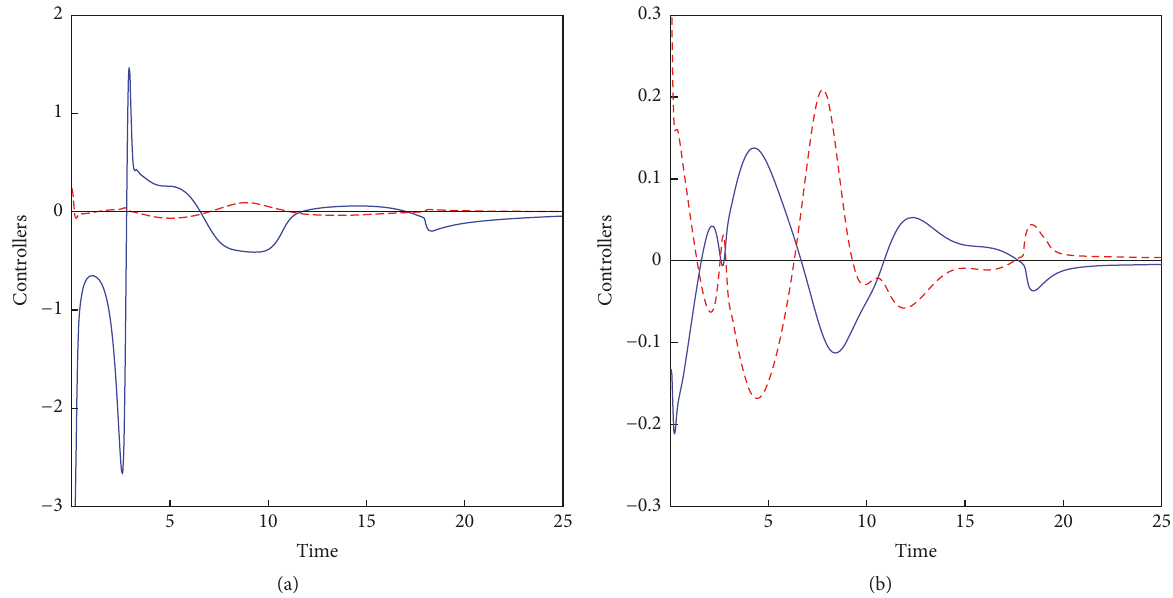
Figure 6: The time evolution of the acceleration-based controllers of the lead-carrier shown in (a) for the wheeled platform and (b) for the 2 links when transporting a rigid object.